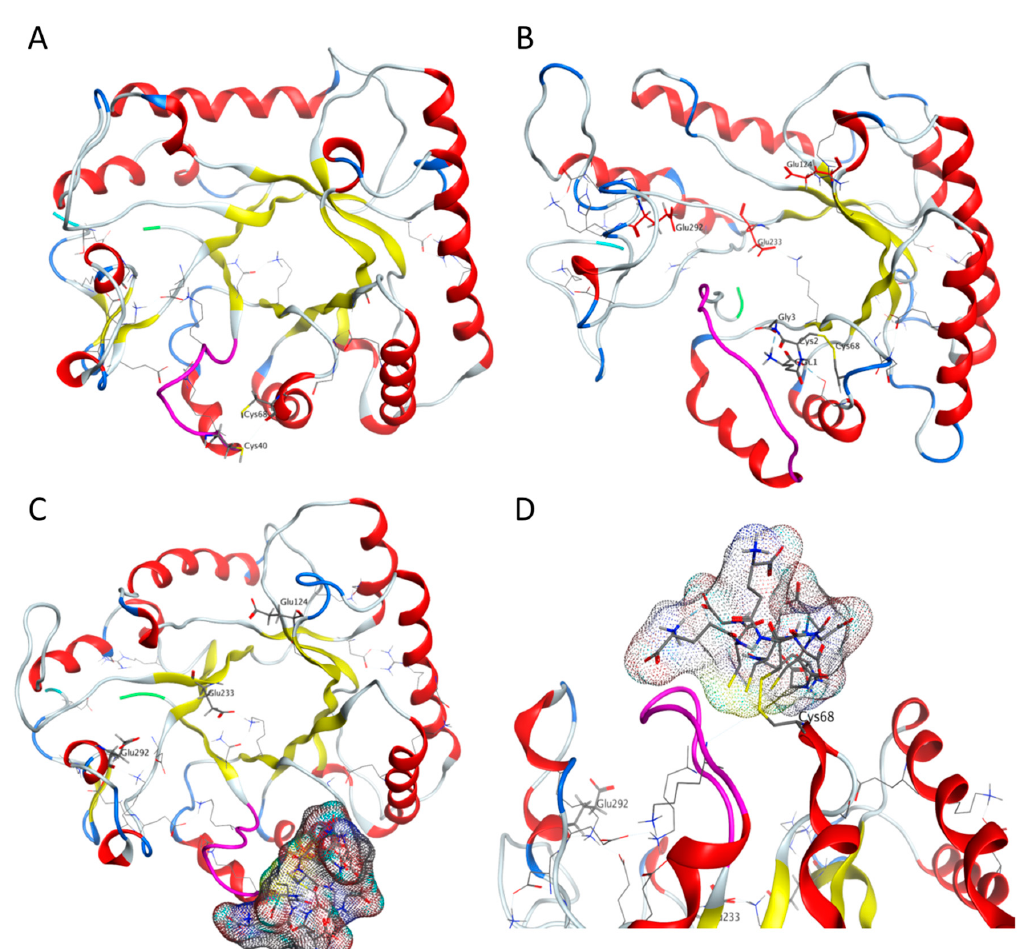
Figure 4. Structural model of Bgl2 molecule without ( A ) and with glutathione ( B – D ). N-terminal is highlighted in green, C-terminal is highlighted in cyan. G32-S42 loop is shown in magenta. The glutathione molecule located in the cavity of Bgl2 greatly changes the structure ( B ). The external location of glutathione molecule does not contribute to significant changes in Bgl2 structure ( C , D ). Possible conformations of glutathione resulting from molecular dynamics simulation are shown as molecular surface (gray area). Axial ( A – C ) and frontal ( D ) views of the cartoon.